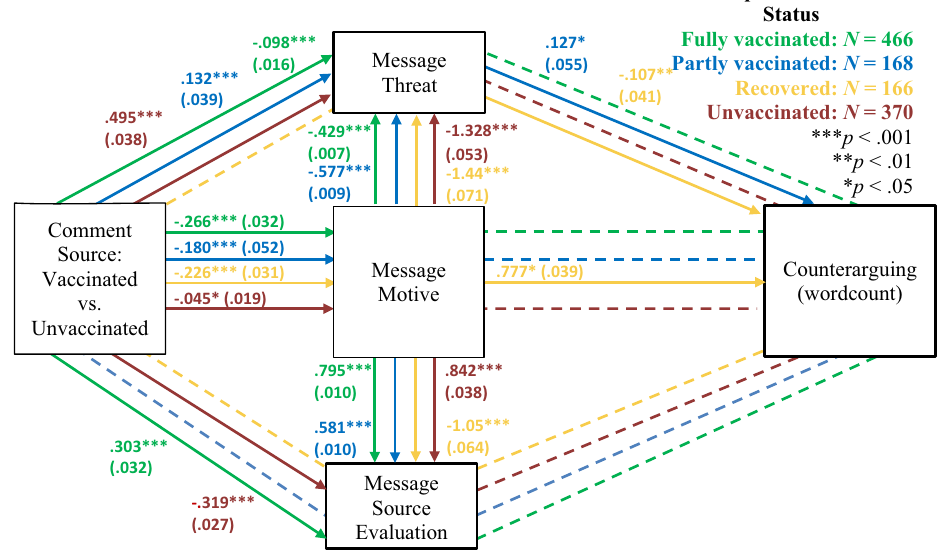
Figure 5. Results of structural equation model analyses on counterarguing by vaccination status. Dashed lines represent non-significant paths. Estimates are standardized regression coefficients and SEs in parentheses; only significant paths are